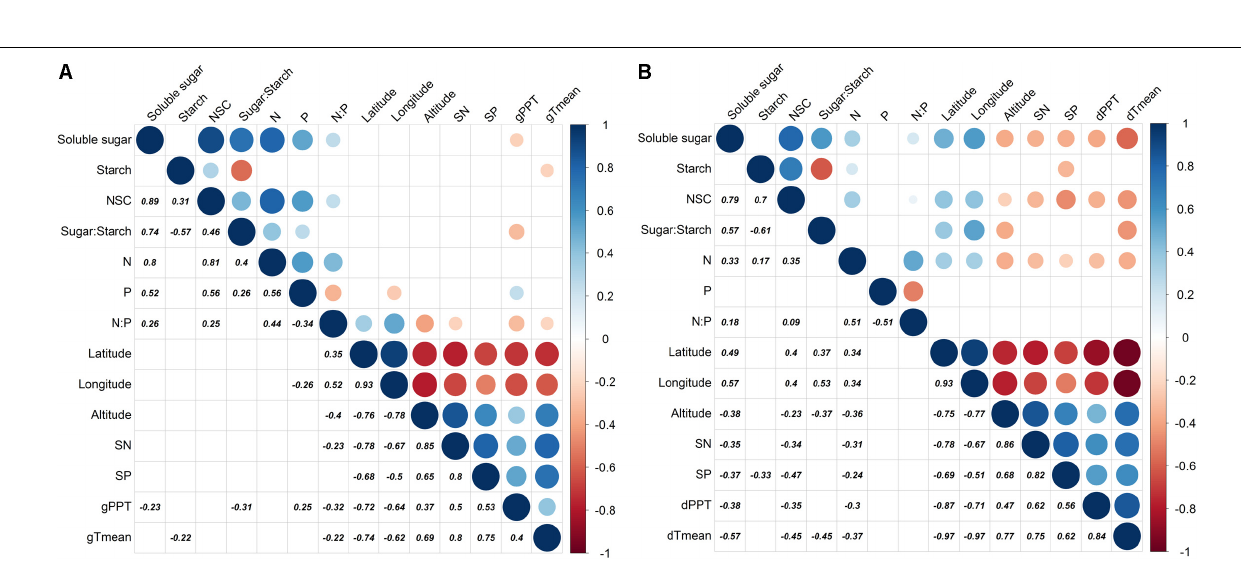
FIGURE 4 | Partial correlation analysis for dependent variables (soluble sugar, starch, NSC, ratio of sugar to starch, N, P, and ratio of N to P) and environmental factors (latitude, longitude, elevation, soil N, soil P, precipitation, and monthly mean temperature) where tree age and tree tissue were regarded as control factors [ (A) : growing season; (B) : dormant season]. Significantly positive or negative correlations ( p < 0.05) are displayed in blue and in red color, respectively; and color intensity and circle size are proportional to the correlation